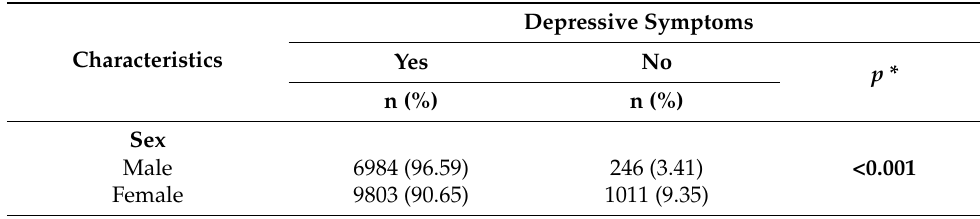
Table 2. Bivariate characteristics of the factors associated with symptoms of depression in patients with